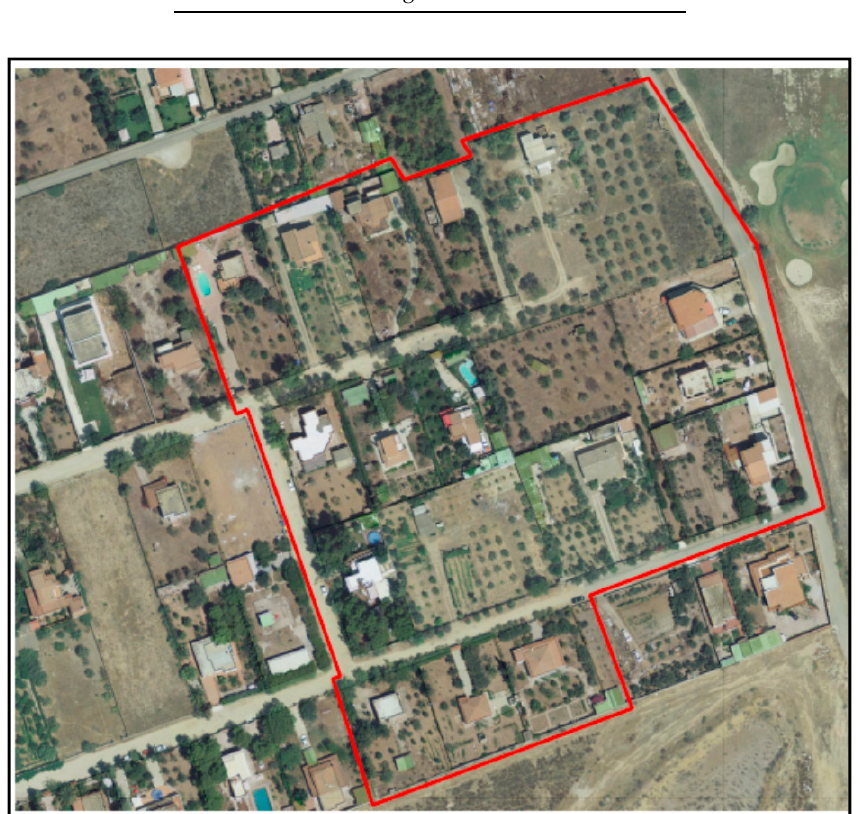
Figure 4. Area surveyed.